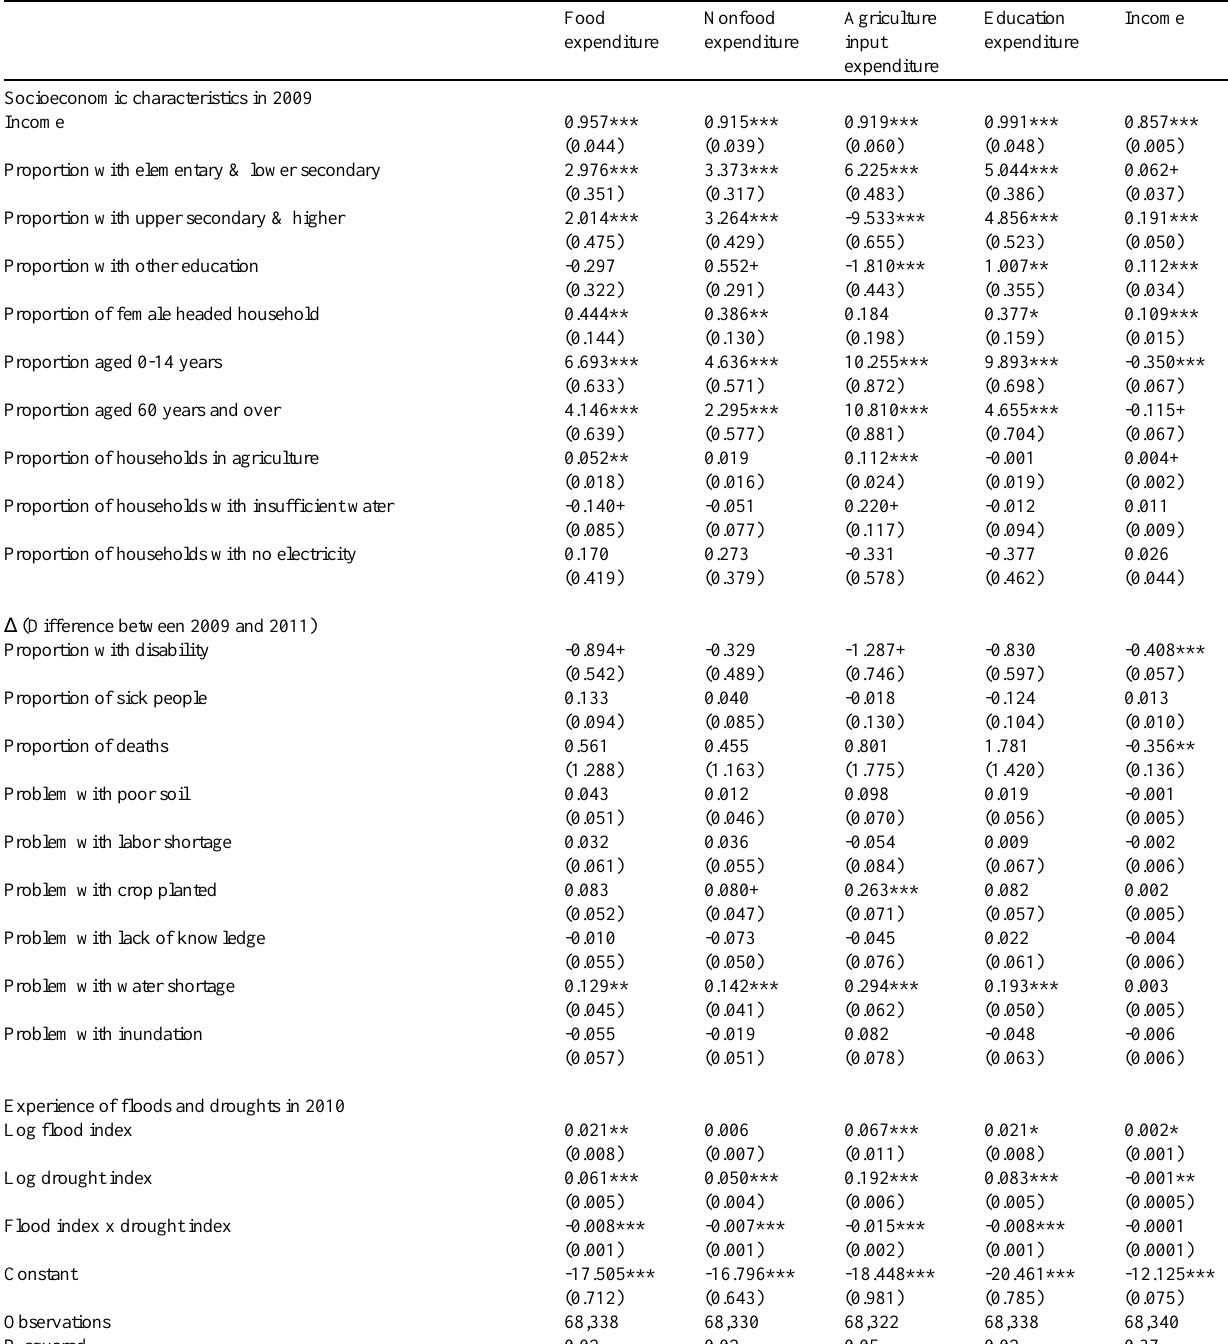
Table 3 . Difference-in-difference estimates of community welfare (standard errors in parentheses): all in